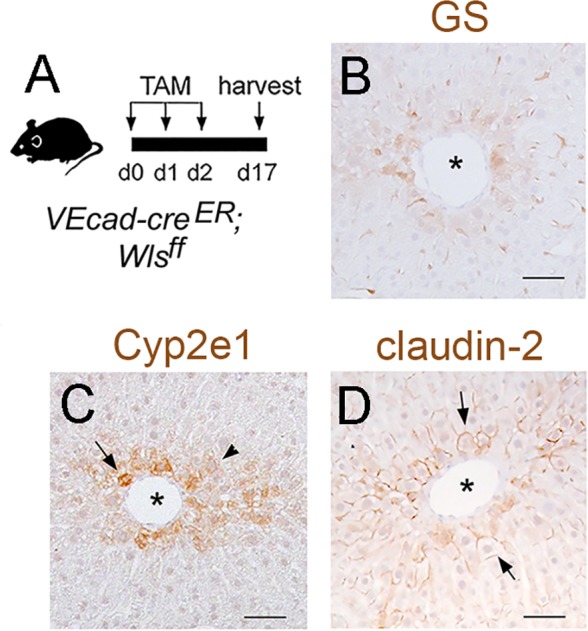
Wls deletion in adult HECs disrupts zonated protein expression in hepatocytes.(A) Schematic of tamoxifen administration and tissue harvesting. (B–D) Immunohistochemistry results showing that Wls endothelial deletion reduces the expression of GS, Cyp2e1 and Claudin-2 proteins in perivenous (asterisks) hepatic areas. Each image represents 2–3 individual livers. Scale bars: 50 µm.